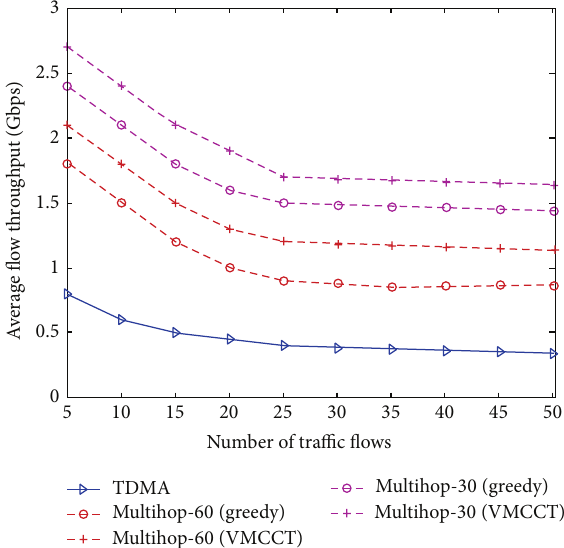
Figure 13: Outage probability with varying 𝑇𝑥 - 𝑅𝑥 distance.